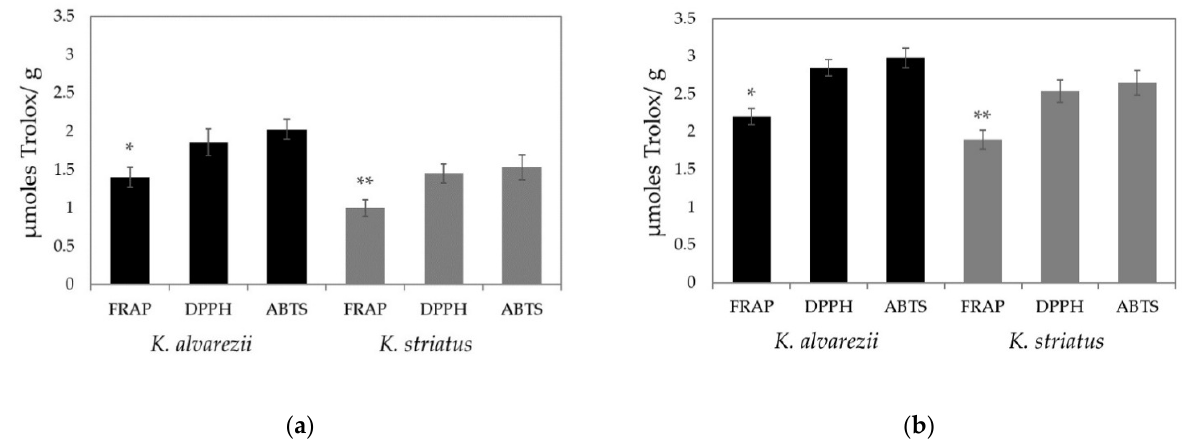
Figure 4. Total soluble ( a ) and fat-soluble ( b ) antioxidant capacities determined in K. alvarezii and K. striatus . The data are represented as the mean ± SD ( n = 36 for each year). The results were analyzed via Mann–Whitney U test: * significant difference ( p < 0.05) of the soluble and fat-soluble antioxidants obtained via FRAP test compared to those determined via DPPH and ABTS assays in K. alvarezii ; ** significant difference ( p < 0.05) of the soluble and fat-soluble antioxidants obtained via FRAP test compared to those determined via DPPH and ABTS assays in K. striatus . No significant difference between the soluble and fat-soluble antioxidant capacity measured by the ABTS and DPPH assays is observable in either species.